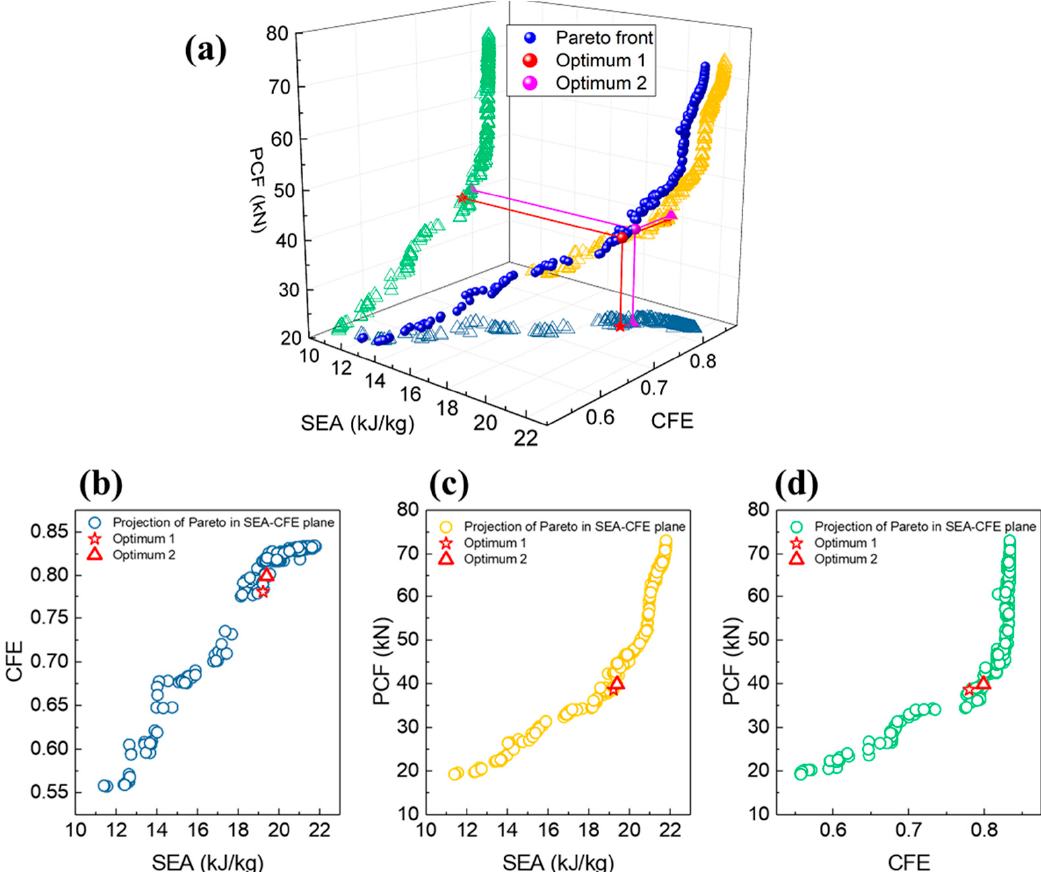
Figure 12. Pareto fronts of the multi-objective optimization: ( a ) three-dimensional view, ( b ) projection in CFE-SEA plane, ( c ) projection in PCF-SEA plane and ( d ) projection in PCF-CFE plane. Table 3. Comparison of the energy absorption performance between the optimum solutions selected from Pareto fronts with the TOPSIS method and the initial design.